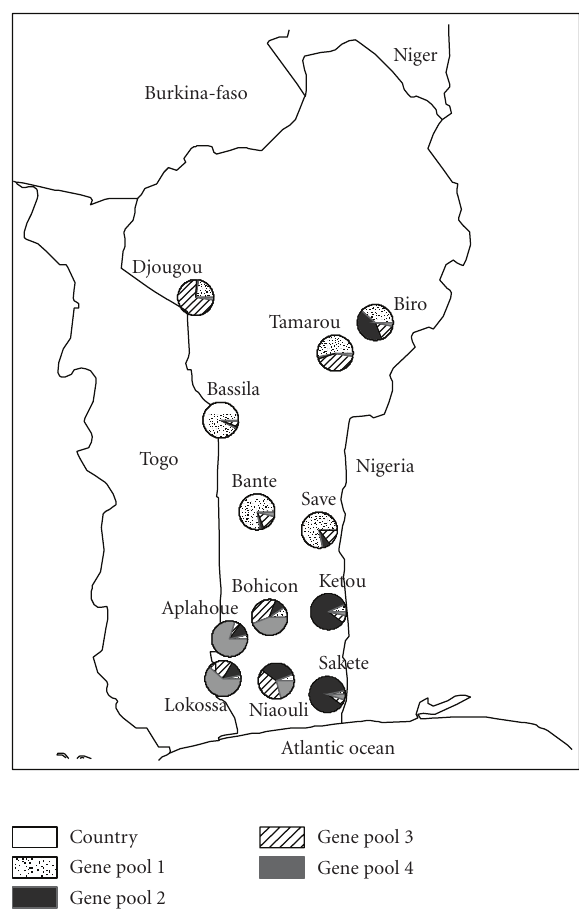
Figure 3: Proportions of ancestry of each population in each of the four gene pools defined with the model-based clustering method from Pritchard et al.